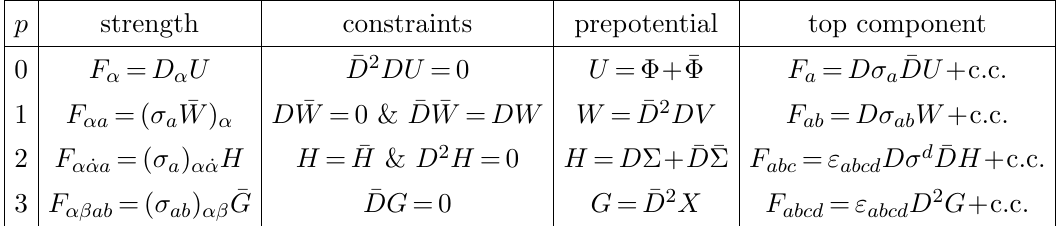
Table 1 . Embedding of p -forms in closed superforms. The component p -forms are embedded into closed super-( p + 1)-form (cid:12)eld-strengths F as originally shown in [15]. Each (cid:12)eld-strength can be written in terms of an invariant scalar or spinor super(cid:12)eld. These satisfy constraints that can be solved in terms of prepotentials. Numerical coe(cid:14)cients are neglected in this table for